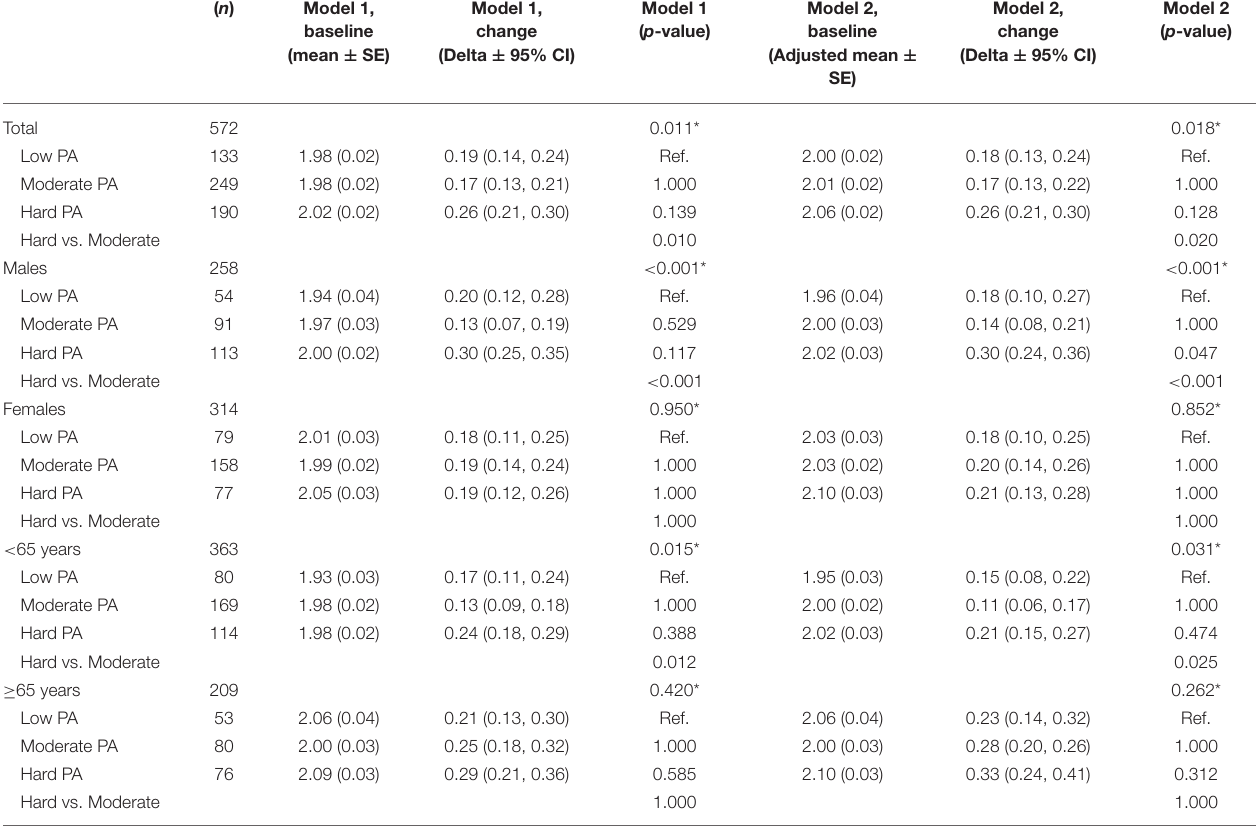
TABLE 2 | Longitudinal associations between cumulative physical activity and change in left atrial diameter index: The Tromsø Study 2007–2016.